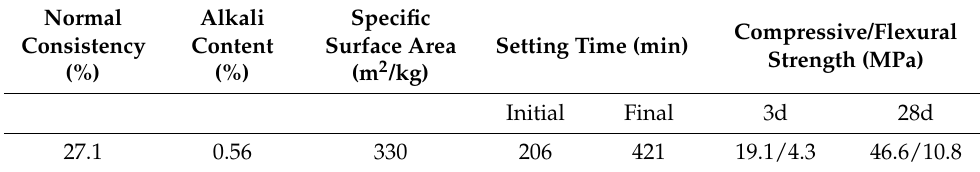
Table 1. Physical properties of cement.